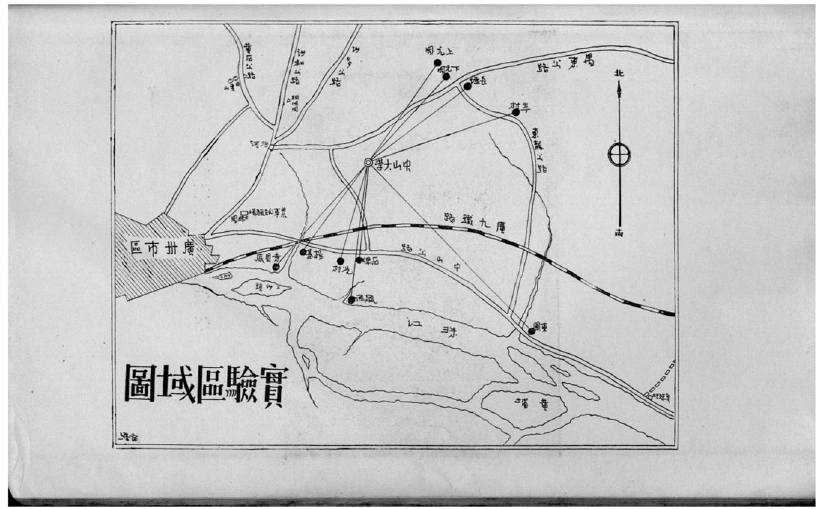
Fig. 3 The experimental area for rural service of Sun Yat-sen University. In 1936, the site of Sun Yat-sen University, Shipai, was surrounded by rural areas, which provided a prerequisite for its rural service experiment, and the establishment of an experimental area near the university made it easy for staff and students to go to carry out their work. The students of Sun Yat-sen University then used the ten villages around Shipai as the experimental